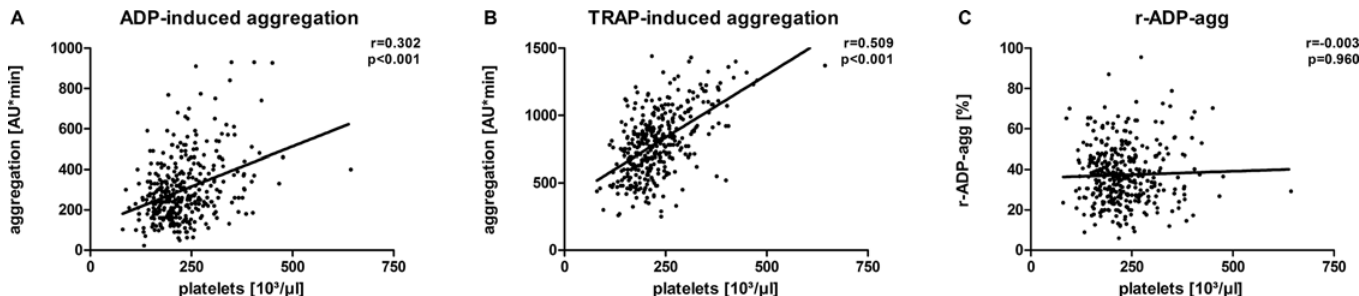
Fig 1. While ADP- and TRAP-induced platelet aggregation correlated significantly with platelet counts the r-ADP-agg values were independent of those.